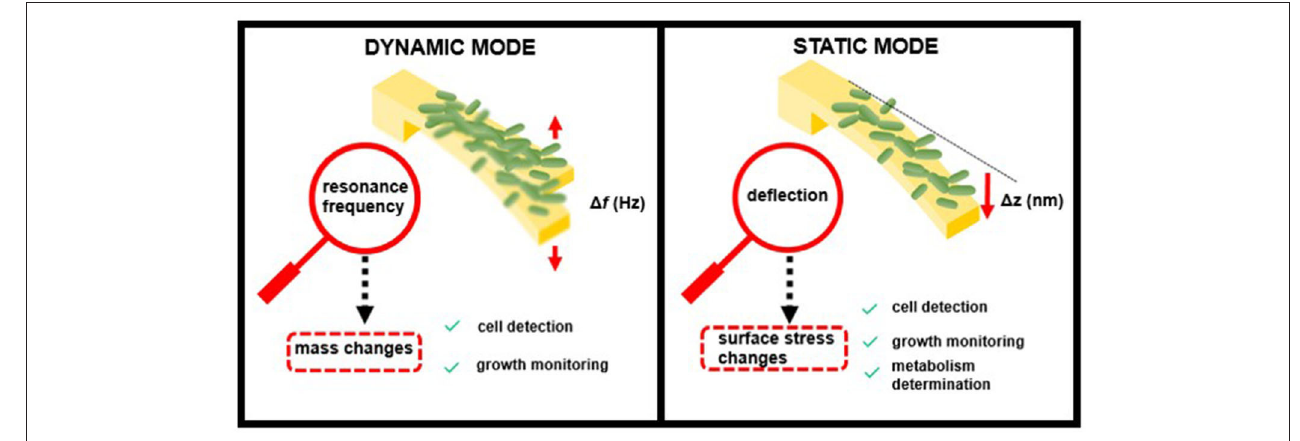
FIGURE 1 | Modes of operation of nanomechanical sensors in bacterial